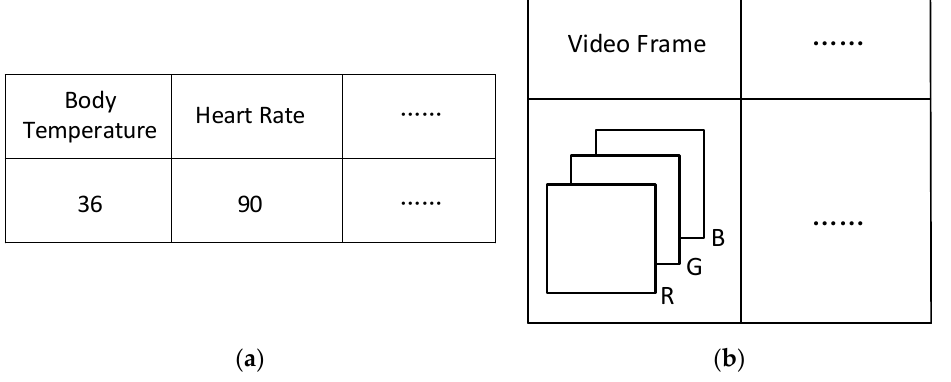
Figure 5. Illustrative toy examples of an element of a third-order tensor. ( a ) (cid:2338) (cid:3036)(cid:3037)(cid:3038) for human object i